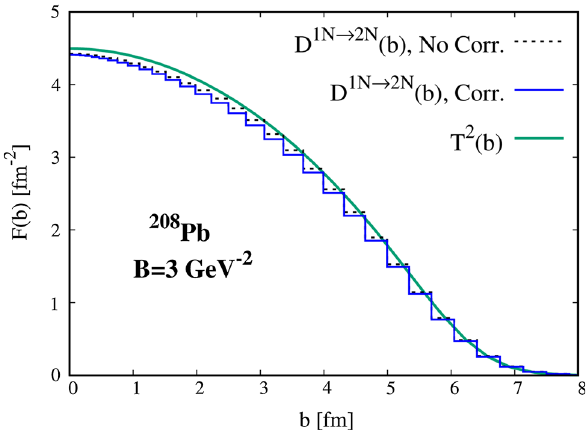
Fig. 5 The impact parameter distributions for scattering off two nucle- onsinopticalapproximation, T 2 ( b ) ,andwithfiniteradiusofinteraction with and without NN correlations, D 1 N → 2 N ( b ) , as defined in Eq. (12)